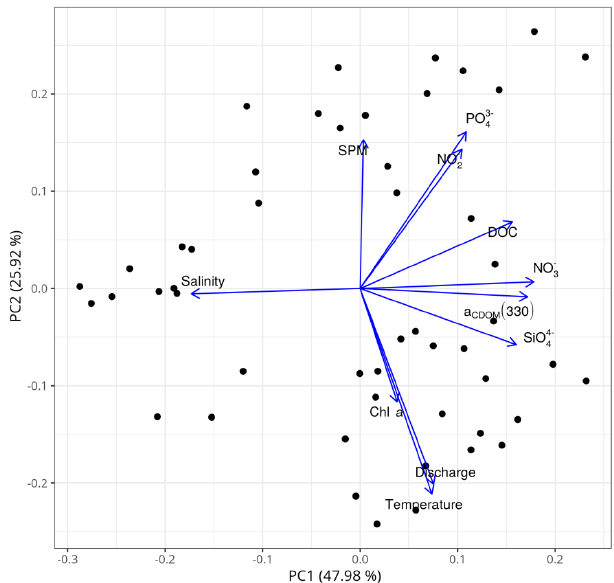
Figure 9. Principal component analysis (PCA) based on the all- cruises dataset for the main estuary. SPM: suspended particulate matter; PO 3 − : phosphate; NO − : nitrite; DOC: dissolved organic 4 2 carbon; a CDOM (330): CDOM absorption coefficient at 330nm; NO − : nitrate; chl a : chlorophyll a ; SiO 4 − : silicate; discharge: 3 4 freshwater discharge rate. The data of SPM, chl a , and nutrients were provided by Li et al.